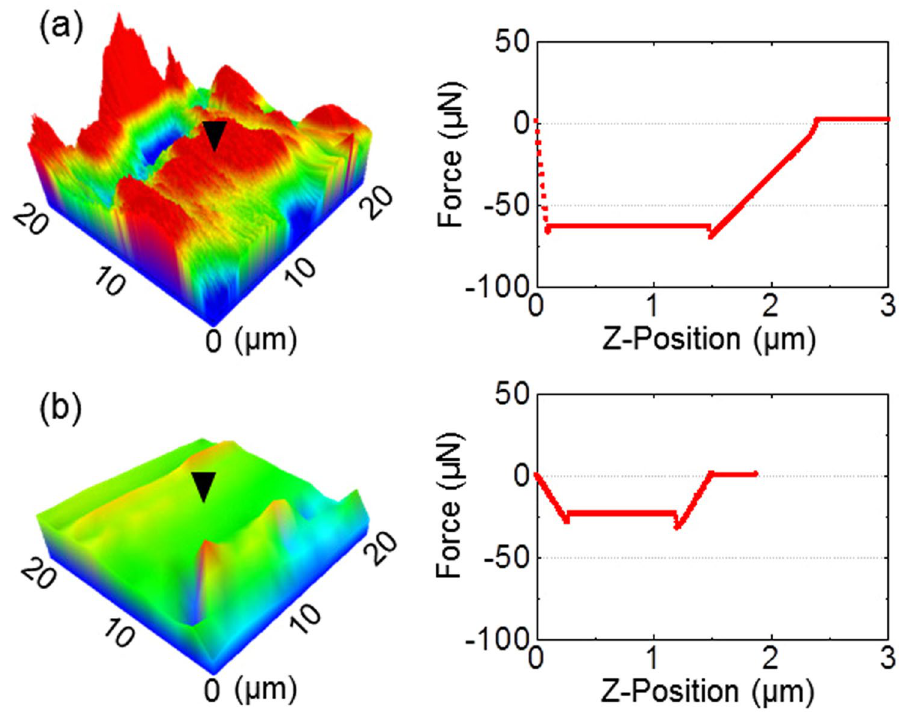
Figure 4. AFM images (left) of morphology of biofilm surfaces and force-distance curves (right) after the treatment with ( a ) DW and ( b ) betaine-erythritol solution. The betaine-erythritol solution contained betaine of 5.6 mM and erythritol of 2.8 mM. The inverted triangle represents where the force-distance curve was